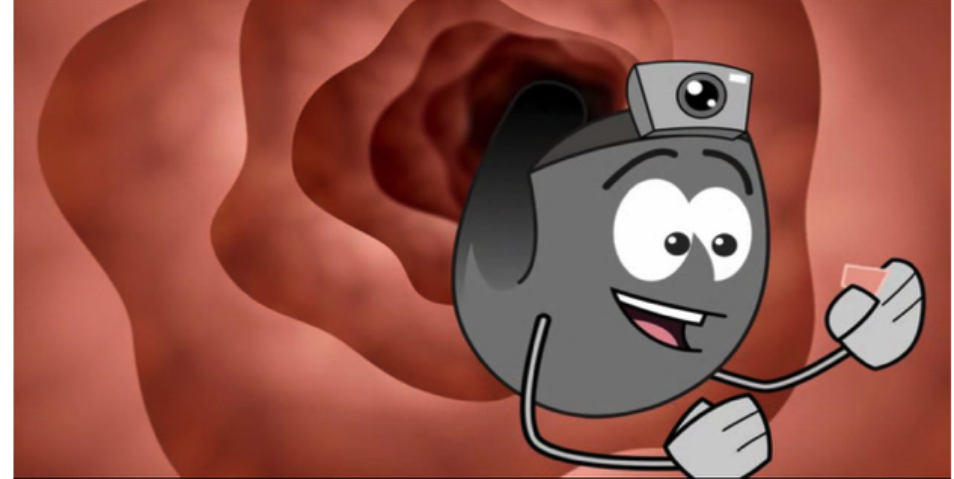
Figure 2. The animated colonoscope “Scopey” featured in the app’s